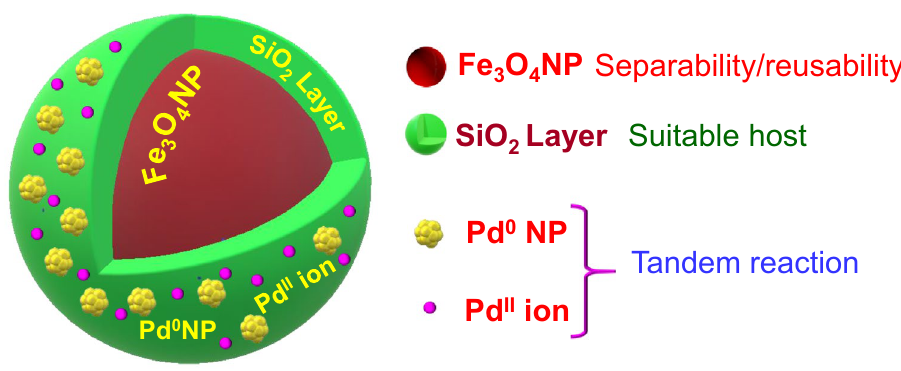
Figure 1. Magnetically retrievable Fe 3 O 4 @SiO 2 /Pd 0 /Pd II NP ( 5 ) nanocatalyst system and its